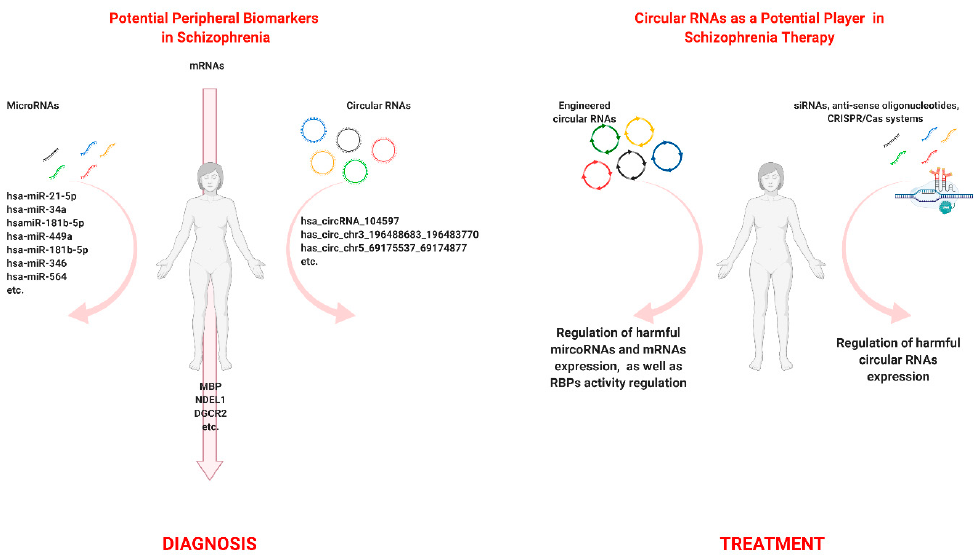
Figure 2. The biomarker and therapeutic potential of circular RNAs in schizophrenia. ( A ) Potential molecular markers in schizophrenia. ( B ) Circular RNAs as a potential player in schizophrenia therapy. Created with BioRender.com.